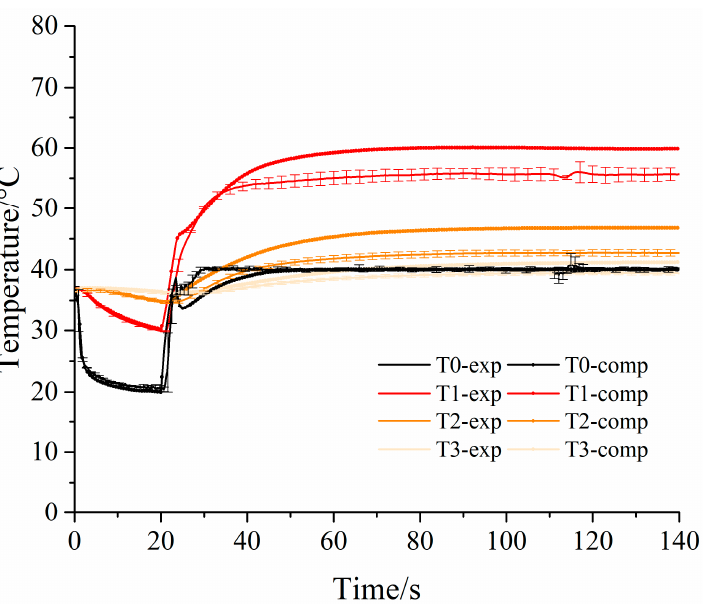
Figure A1. Comparison of the experimental data and numerical calculation results to validate the theoretical model. T0-exp, T1-exp, T2-exp, and T3-exp and T0-comp, T1-comp, T2-comp, and T3-comp are T0, T1, T2, and T3 in the experiment and computational model.